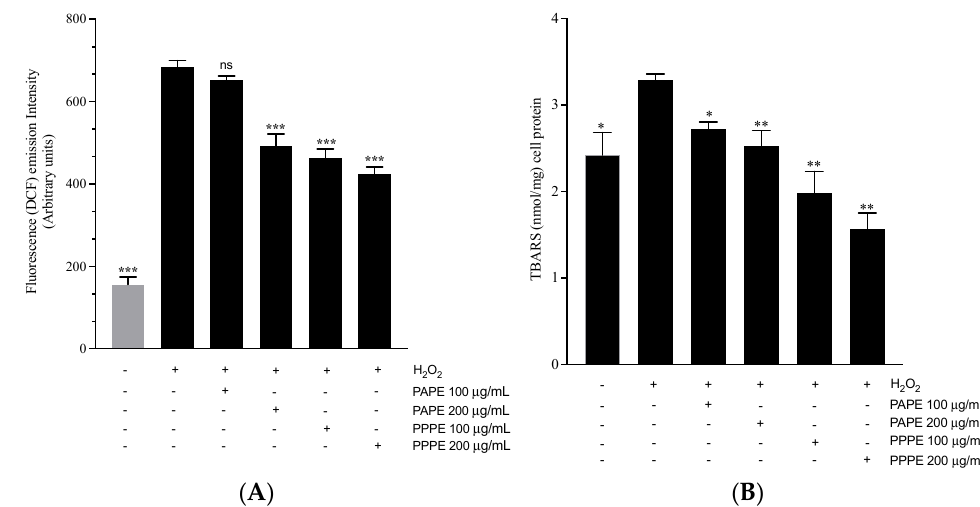
Figure 5. ( A ): Intracellular radical scavenging activity of PPPE and PAPE. J82 cells were treated with 100 or 200 µ g/mL of PPPE or PAPE. Cells were labelled with 10 µ mol/L DCFH-DA. The DCF fluorescence intensities were measured. The results are expressed as the means ± sem of more than three independent assays. *** p < 0.001 indicates a significant difference compared to the control. ( B ): Effects of PPPE and PAPE on TBARS levels in J82 cells. TBARS levels were assessed using a spectrophotometer. All values are expressed as the means ± sem of three independent